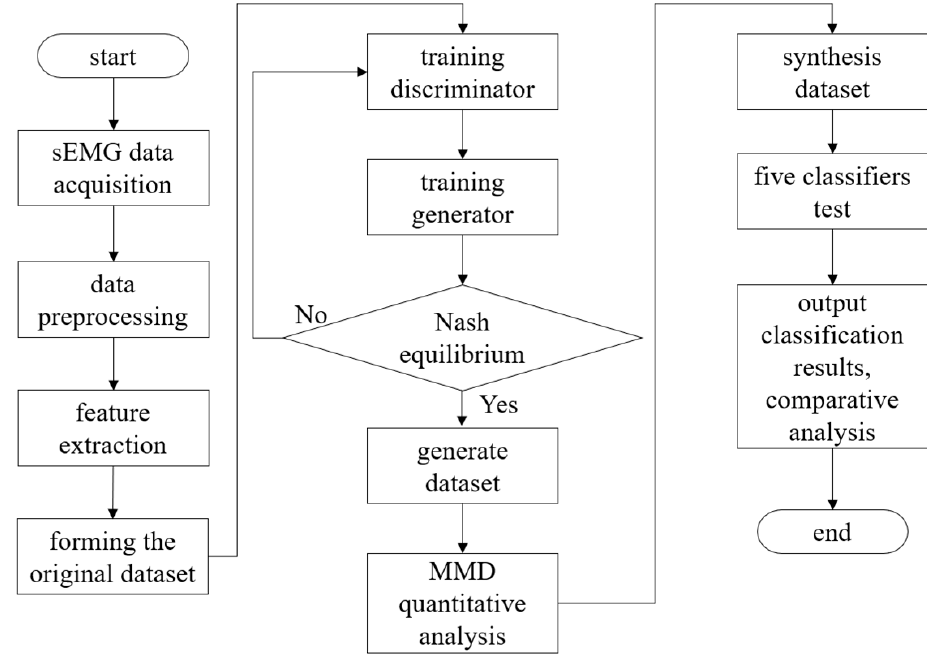
Figure 6. Flowchart of the data generation and classification performance test.